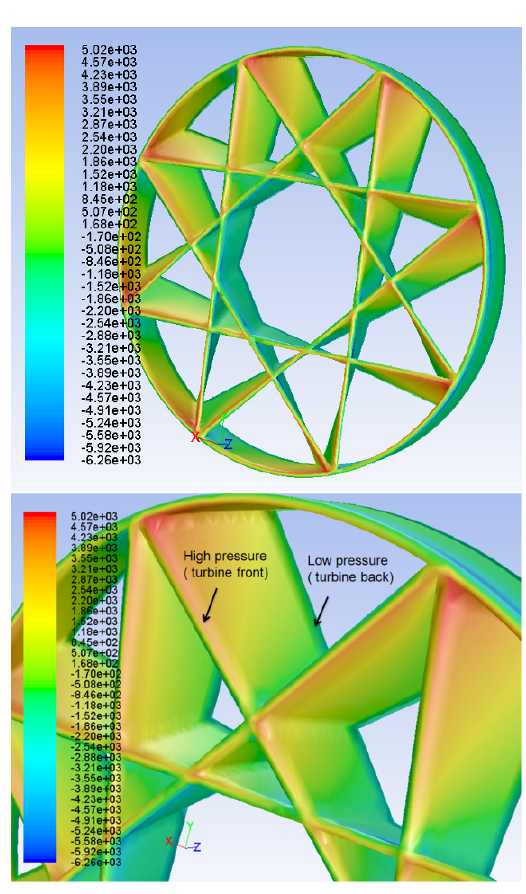
Figure 5. Static pressure distribution on the turbine.